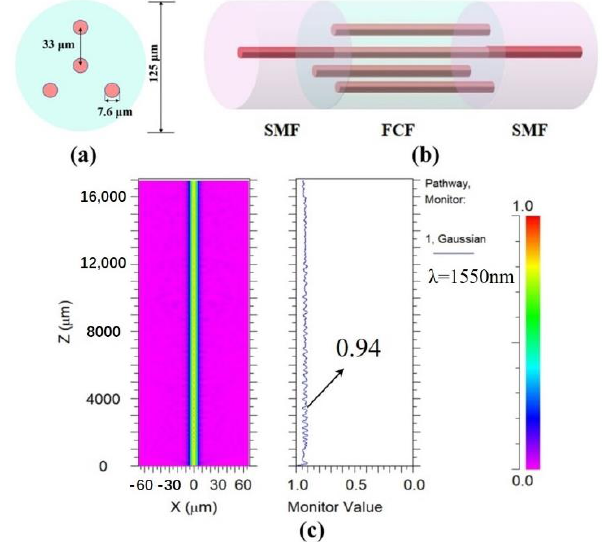
Figure 1. ( a ) The cross section of FCF; ( b ) the schematic diagram of the SMF – FCF – SMF fiber structure; ( c ) Simulated light field distribution of SMF – FCF – SMF structure.